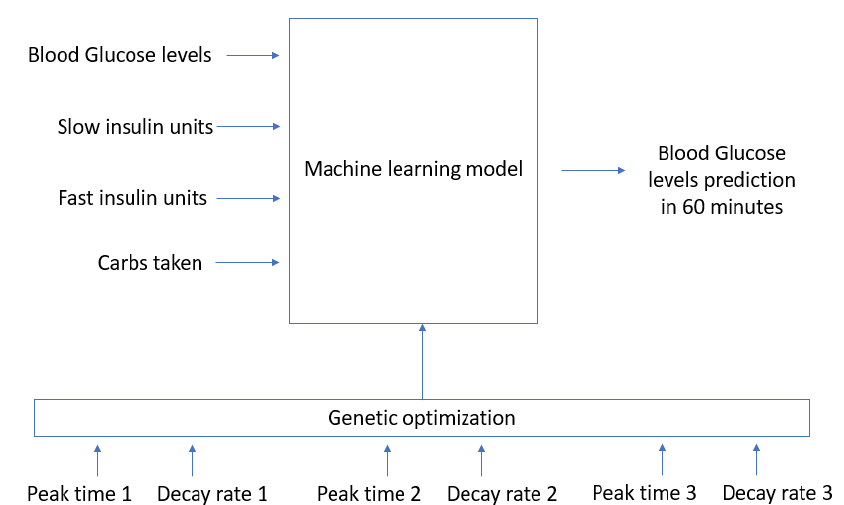
Figure 3. Genetic optimization to find the optimal values for the generated curves.